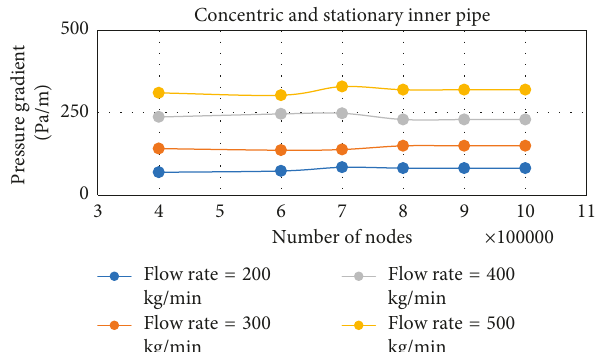
Figure 5: Mesh independence analysis.